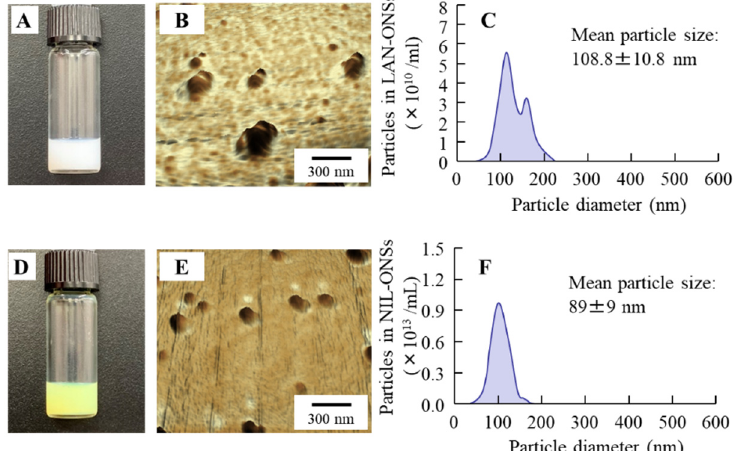
Figure 1. Images and particle sizes of ophthalmic formulations containing LAN and NIL nanoparticles. A and B: digital image ( A ) and AFM image ( B ) of LAN-ONSs. ( C ): particle size frequencies of LAN-ONSs. D and E: digital image ( D ) and AFM image ( E ) of NIL-ONSs. ( F ): particle size frequencies of NIL-ONSs. Bar, 300 nm. Both of the LAN-ONSs and NIL-ONSs appeared cloudy, and the mean particle sizes of the LAN-ONSs and NIL-ONSs were 108.8 nm and 89.0 nm, respectively.